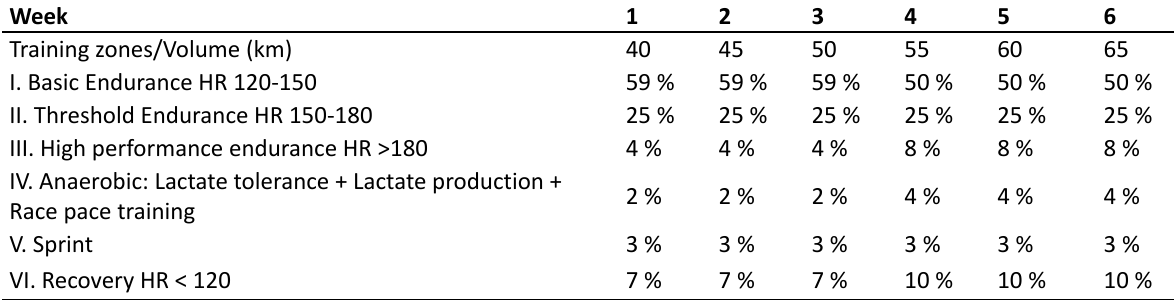
Table 1 . Six-week training programme of the elite swimmers from this study